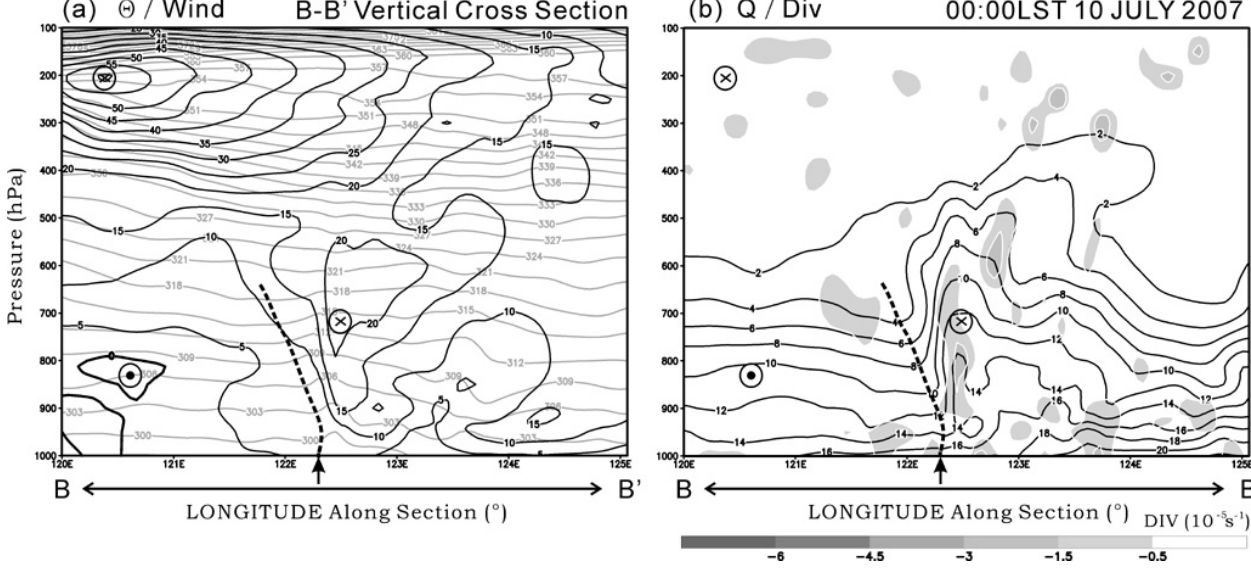
Fig. 6. Same as Fig. 5 except for line B–B 0 (from 120 ◦ E, 36 ◦ N to 125 ◦ E, 29 ◦ N) in Fig.